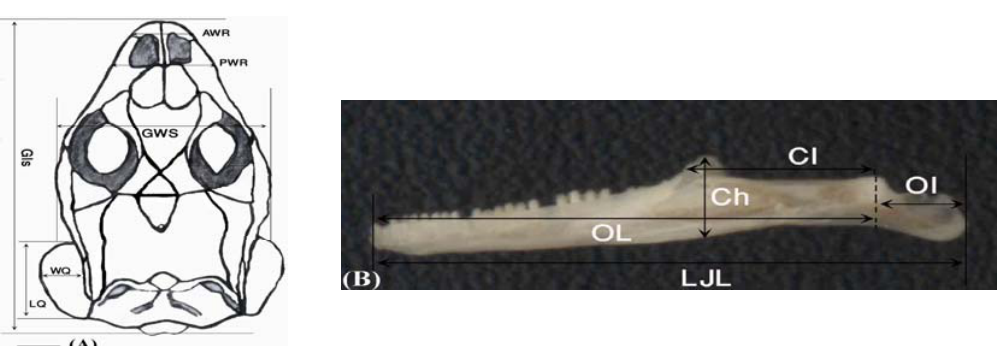
F IG .2.- Quantification of tooth and skull dimensions. (A). dorsal view of the skull of Trachylepis